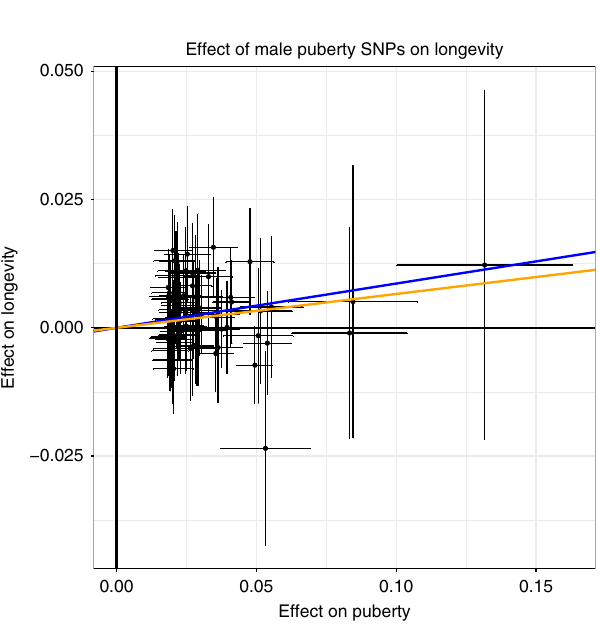
Fig. 3 Effect of male puberty SNPs on longevity. Scatterplot of 73 male puberty loci (pruned for heterogeneity) comparing effect sizes for puberty timing (from MTAG) and longevity. Lines show results of different Mendelian randomisation models: IVW (blue), weighted median (yellow). Error bars indicate 95% con fi dence intervals for individual SNP associations.